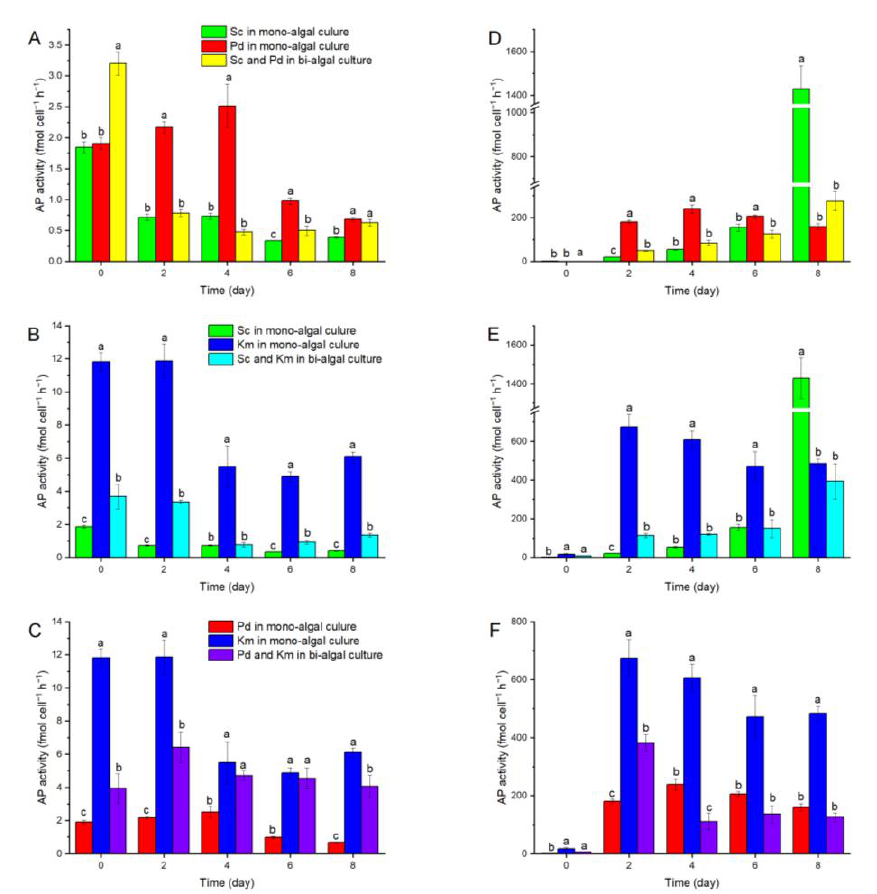
Figure 6. The AP activity changes of P. donghaiense , S. costatum and K. mikimotoi in mono- and bi- algal cultures under P-sufficient ( A – C )/deficient ( D – F ) conditions, respectively. The values are the mean ± S.D. ( n = 3), with the different lower-case letters indicate significant ( p < 0.05) differences among the two mono-algal cultures and bi-algal culture.